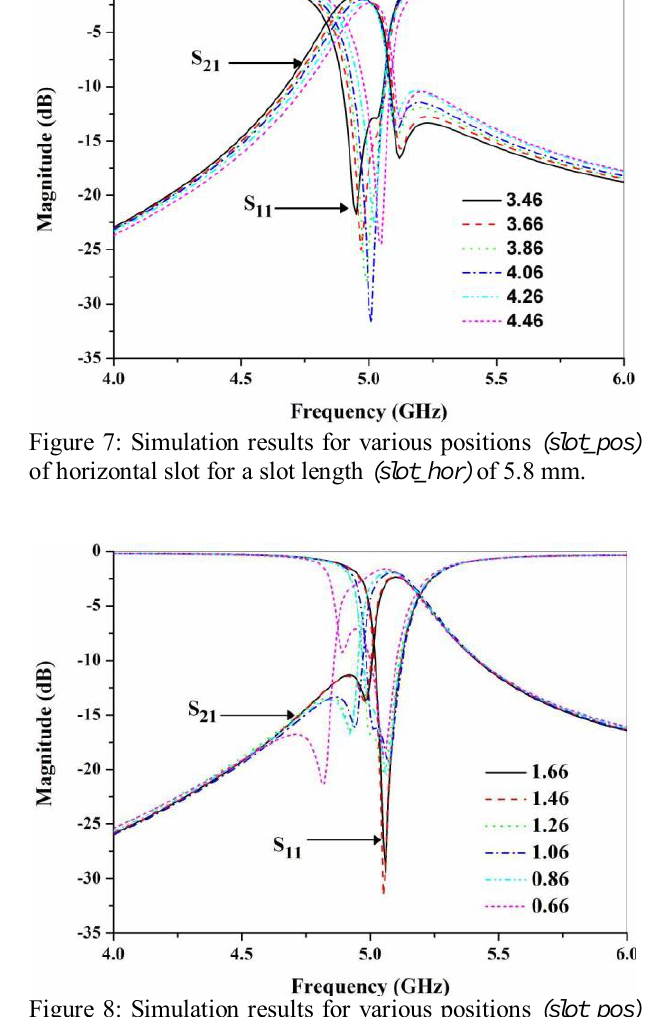
Figure 6: (a) Two-pole bandpass filter using horizontal slot (Filter A), (b) two-pole bandpass filter using vertical slot (Filter B), (c) four-pole filter using both horizontal and vertical slots (Filter C).